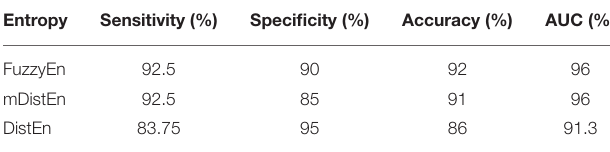
TABLE 1 | Performance evaluation of the different